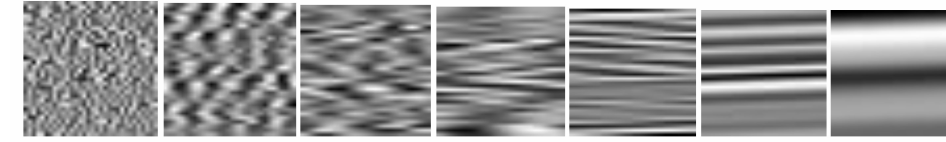
Figure 9. The corresponding grey images of the first seven orders of the IMF